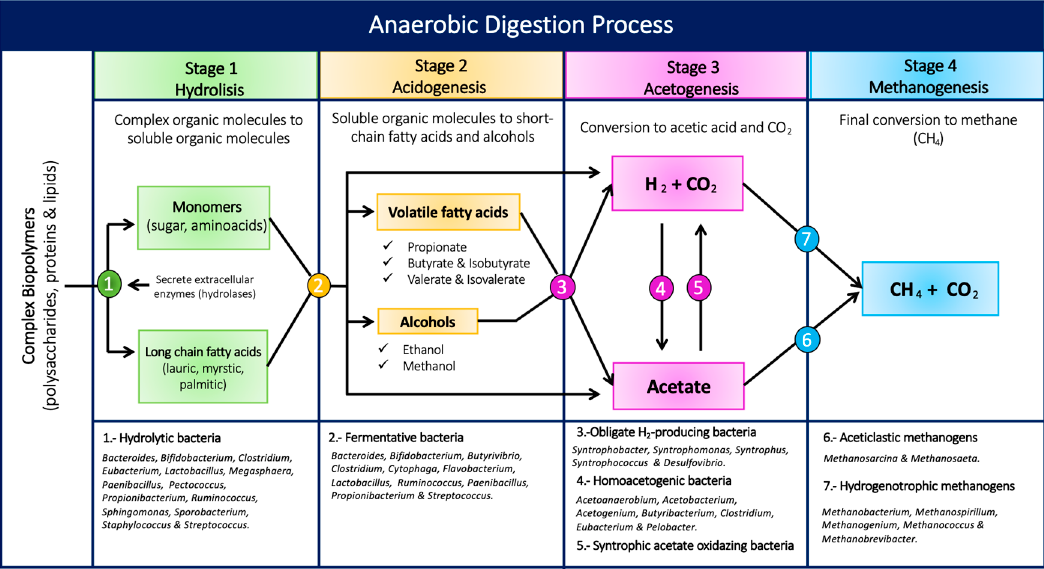
Figure 2. Schematic representation of anaerobic digestion process.